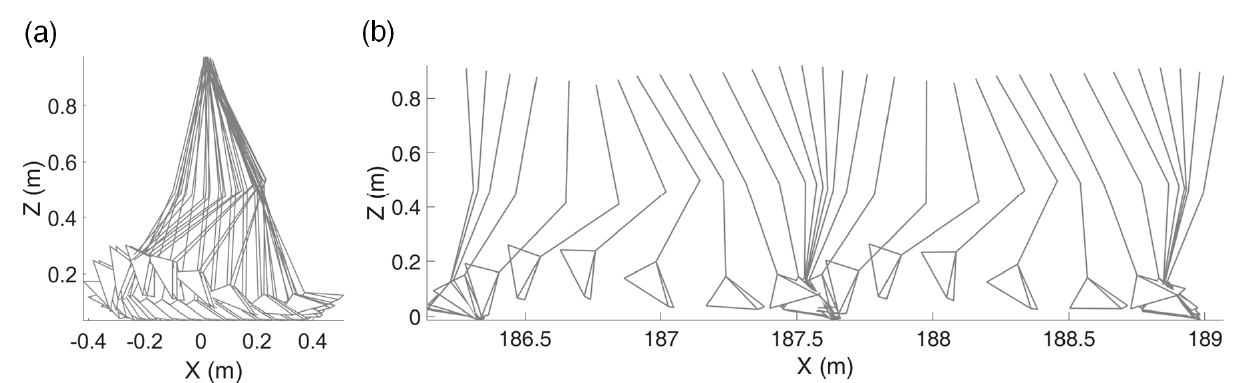
Figure 1. Examples of walking trajectory from each system during the same treadmill walking test: ( a ) trajectory from a marker-based optical motion capture (MoCap) system, ( b ) trajectory estimated using inertial measurement unit (IMU) signals.